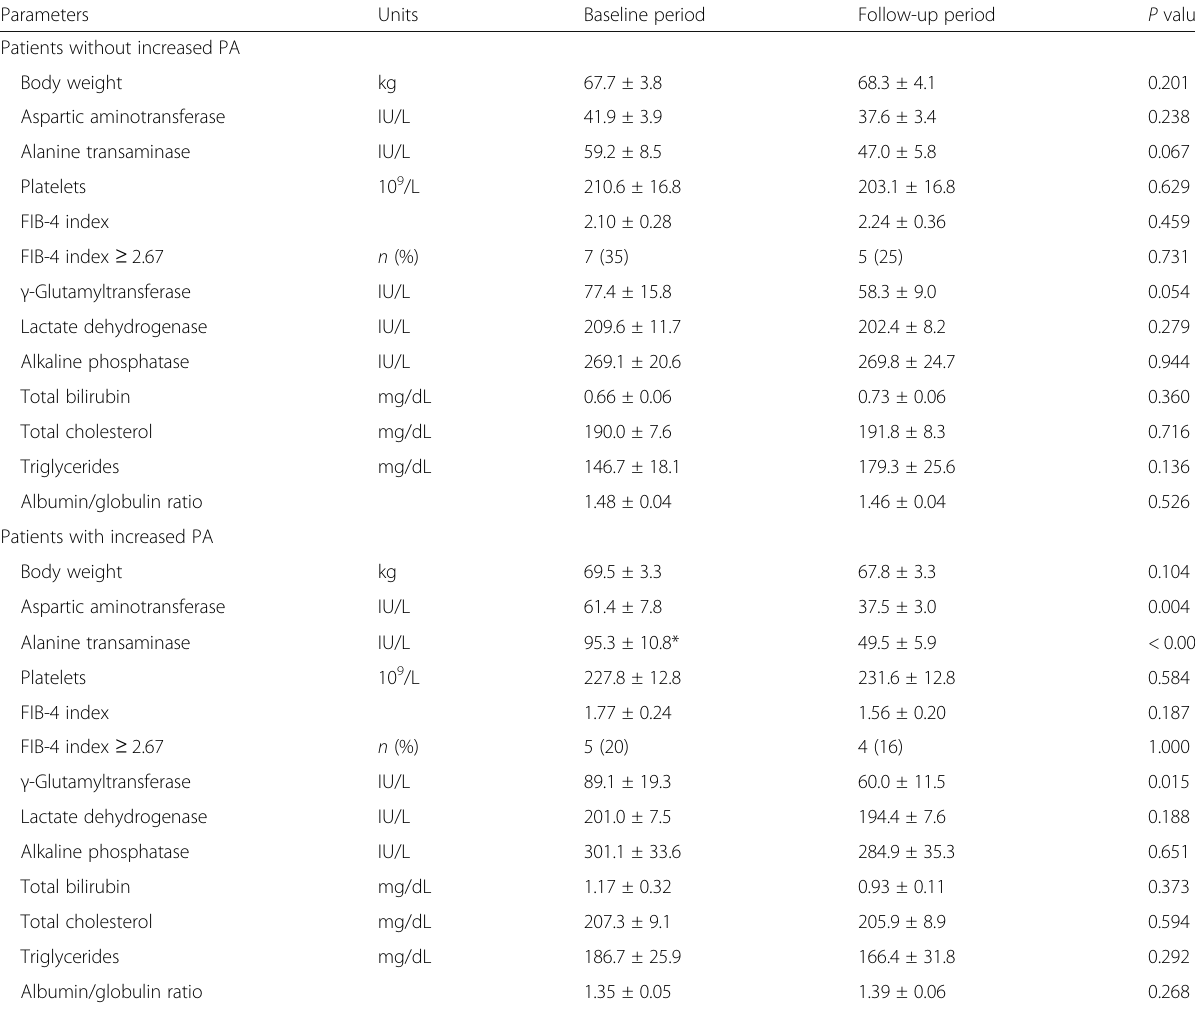
Table 2 Differences in clinical parameters in patients with or without increased physical activity Parameters Units Baseline period Follow-up